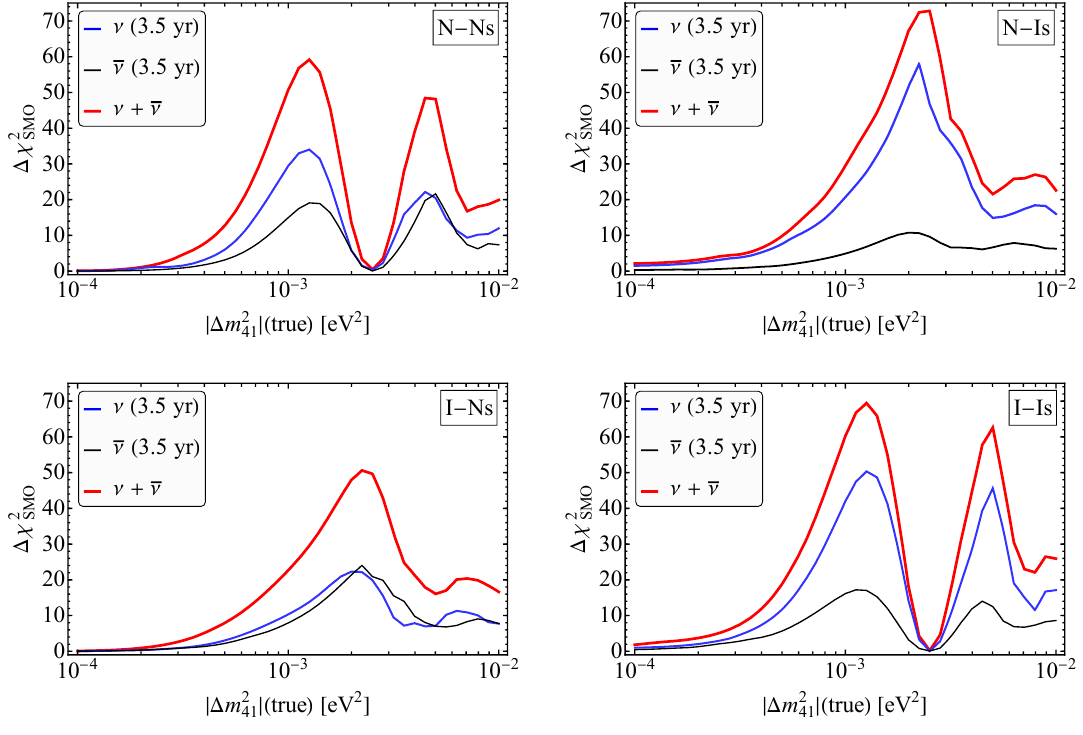
Figure 5 . Same as the figure 4, but for all four mass ordering combinations (N-Ns, N-Is, I-Ns, I-Is). We show only the results with test parameters varied over the range indicated in table